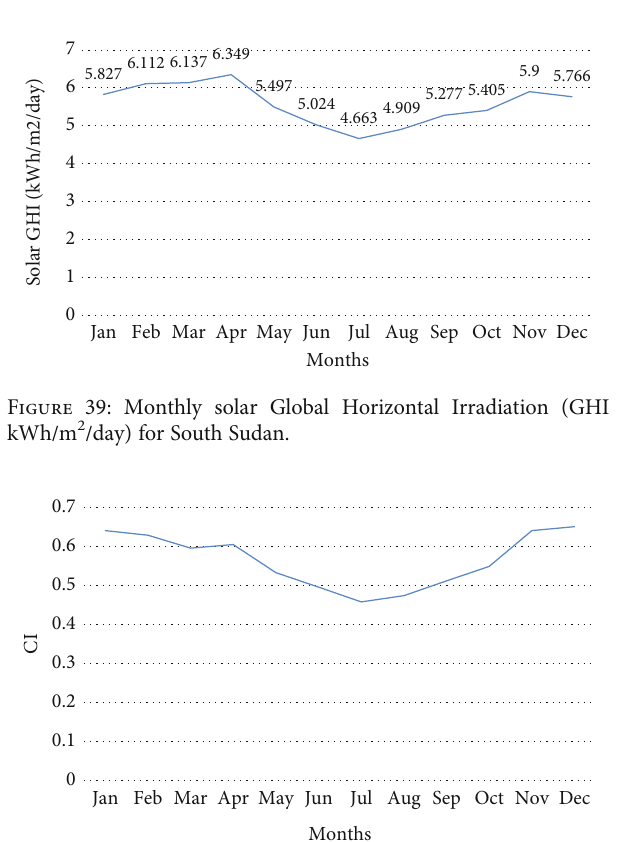
Figure 38: Image of a containerized minigrid system in South Sudan (Source: Aptech Africa).